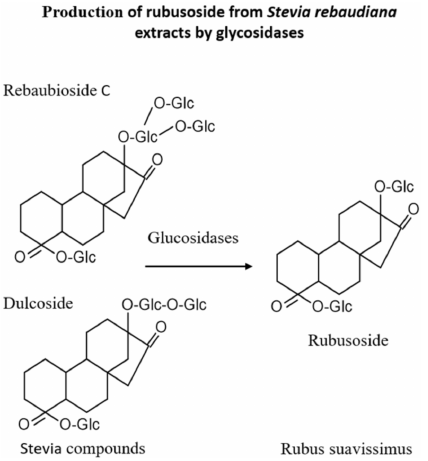
Figure 4. Rubuside production from Stevia reaudiana